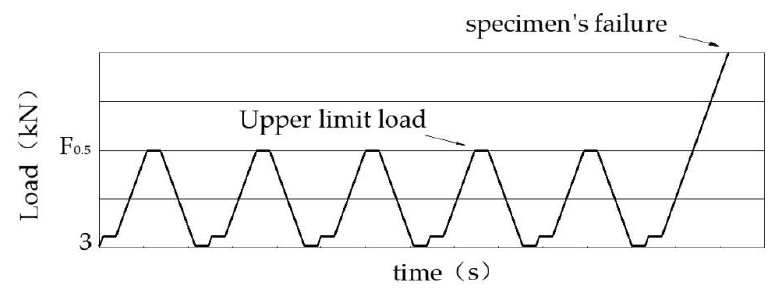
Figure 3. Bending stress–strain schematic.